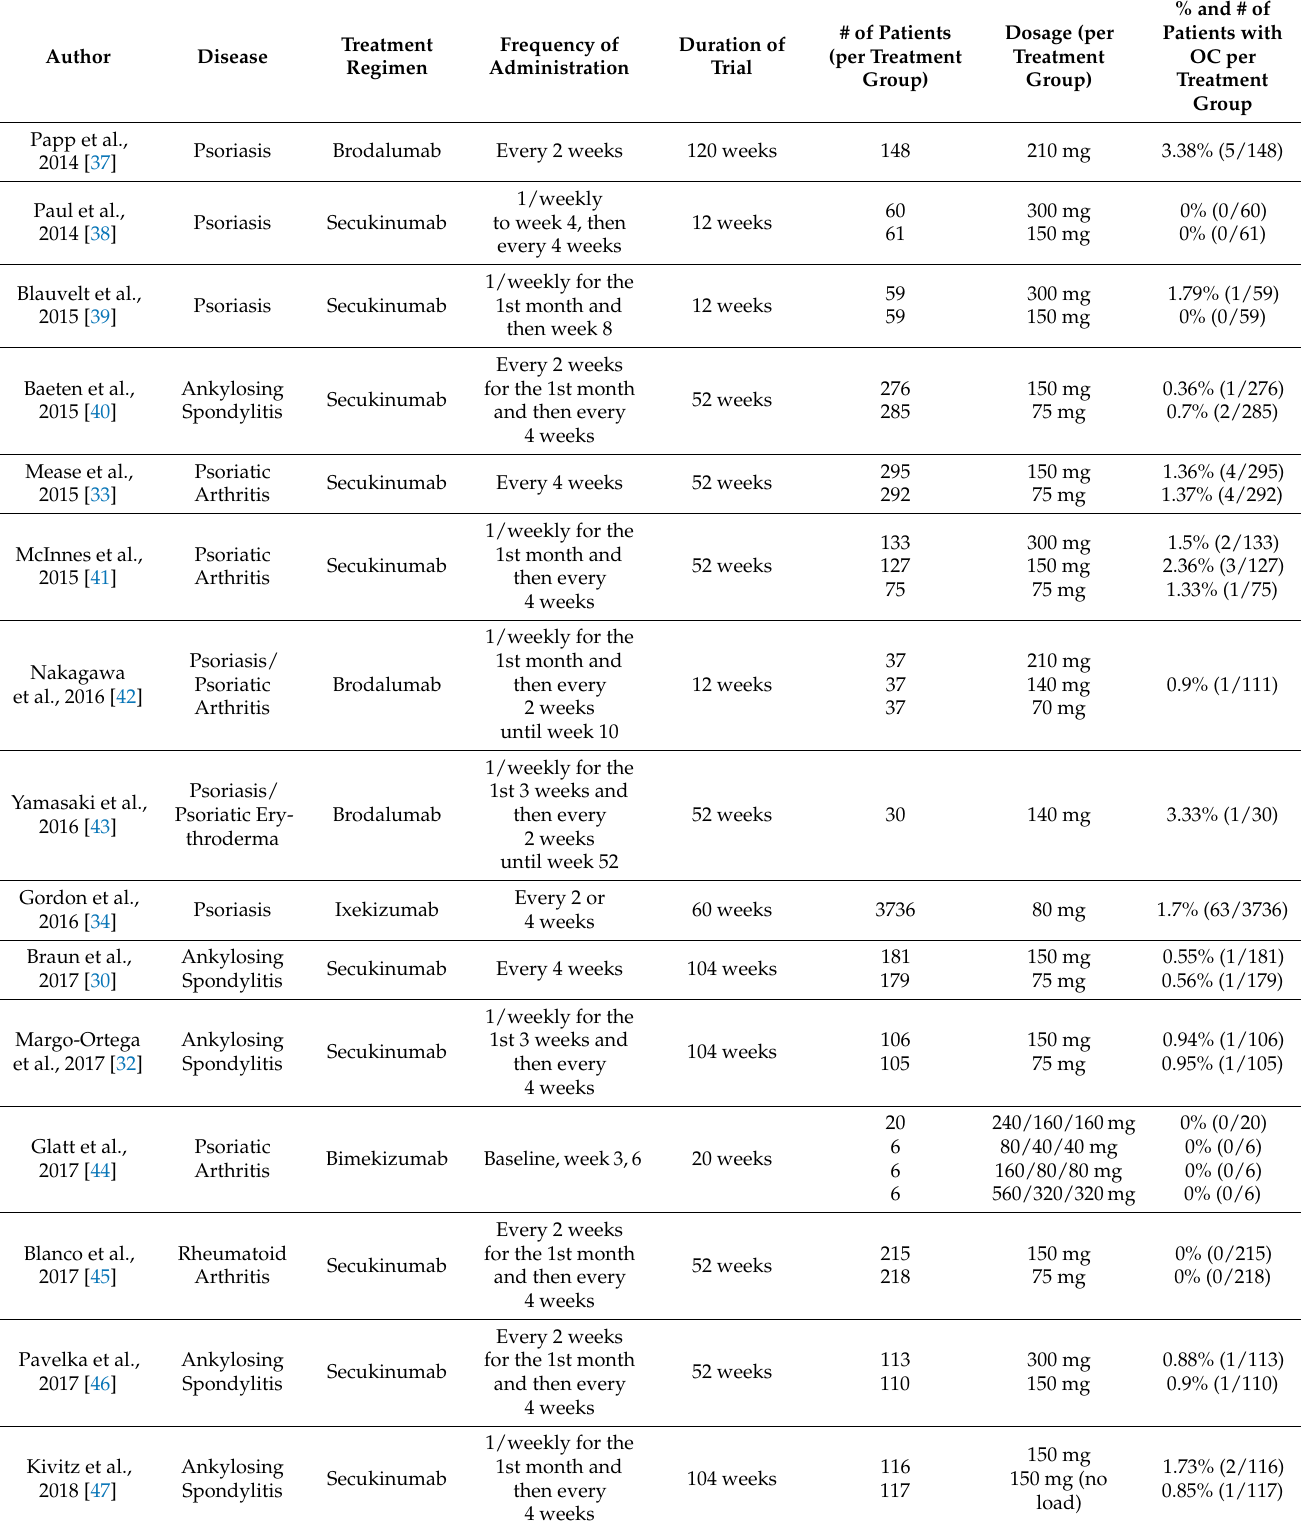
Table 1. Summary of clinical trials of IL17 inhibitor treatment for psoriasis, psoriatic arthritis, ankylosing spondylitis, and rheumatoid arthritis, specifically reporting oral candidiasis development as an adverse